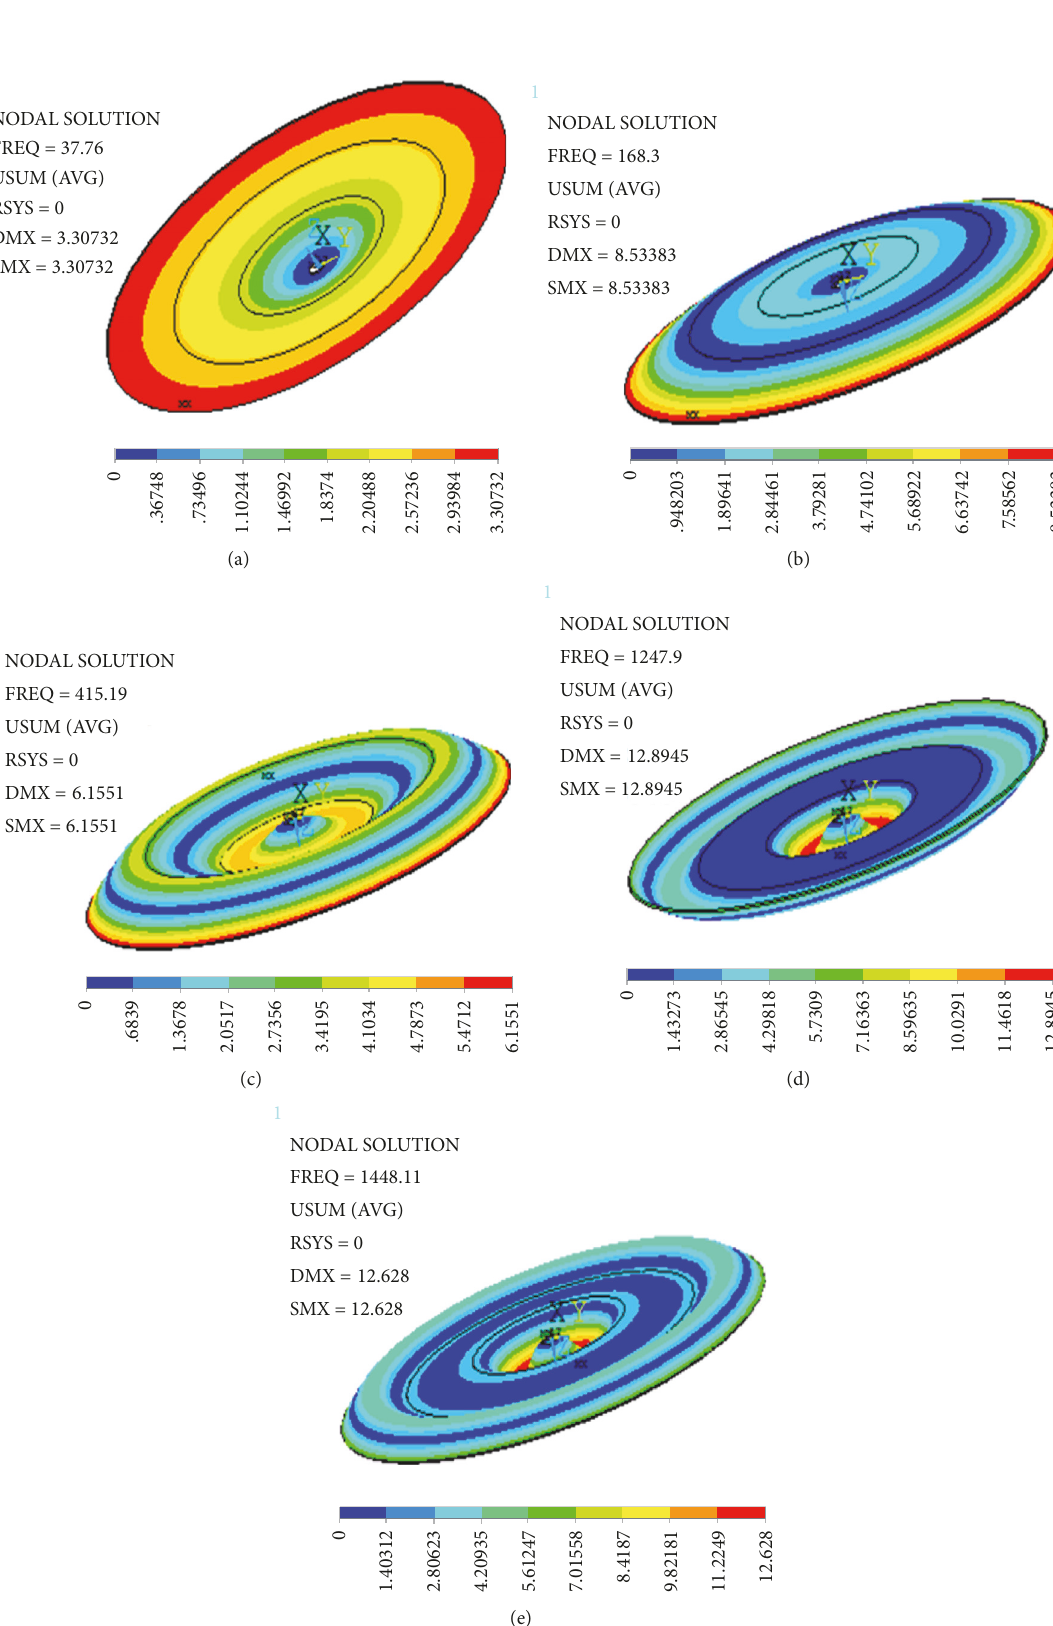
Figure 4: Mode shapes of natural frequencies. (a) First mode. (b) Second mode. (c) Third mode. (d) Fourth mode. (e) Fifth